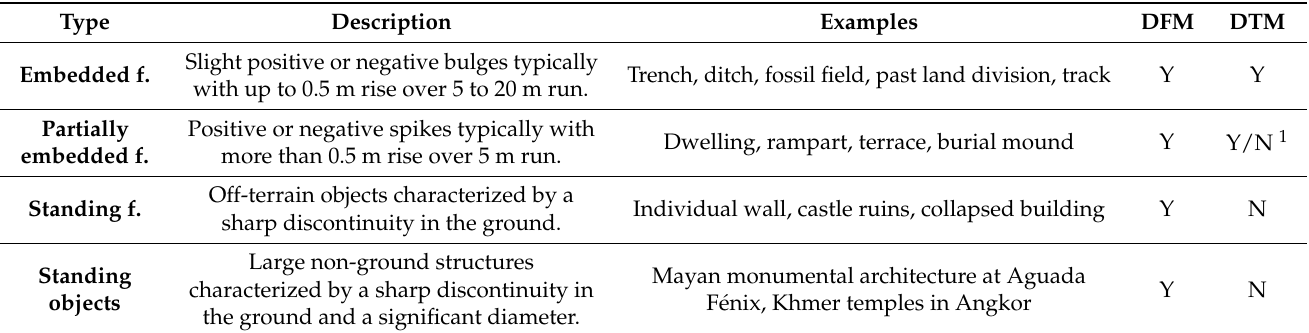
Trench, ditch, fossil field, past land division, track Y Y